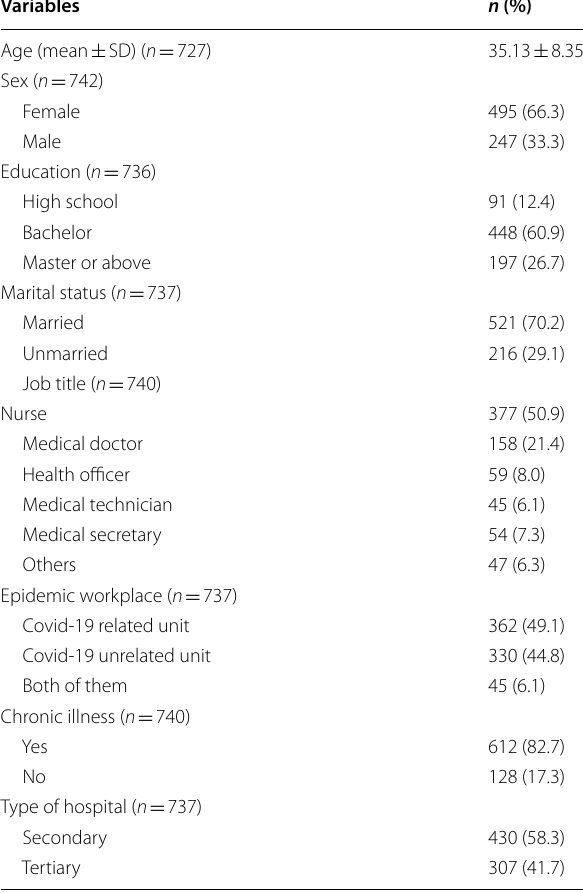
Table 3 Sleep parameters of healthcare workers those working